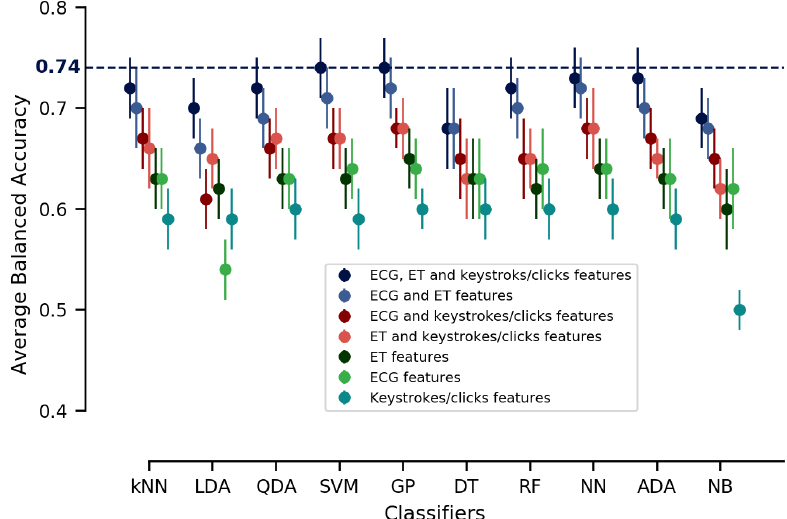
Figure 10. Average balanced accuracy for 20 × 5-fold cross-validations and the 95% confidence interval. Input features were conditioned on the automation level of the robot, which constitutes an additional common input feature for all tests. kNN: k-Nearest Neighbors; LDA: Linear Discriminant Analyses; QDA: Quadratic Discriminant Analyses; SVM: Support Vector Machine; GP: Gaussian Process; DT: Decision Trees; RF: Random Forest; NN: Neural Network; ADA: AdaBoost; and NB: Naive